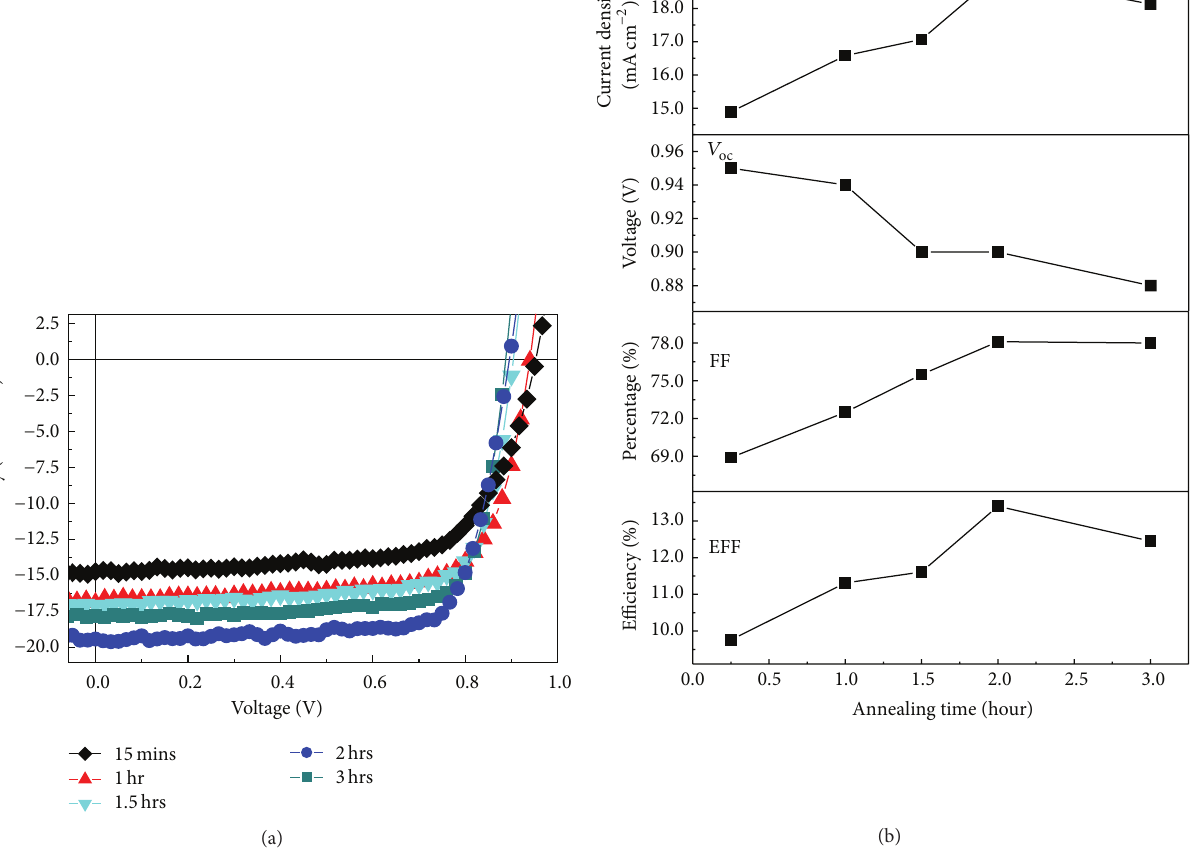
Figure 7: Electrical performance of devices with MAPbI 3 perovskite films annealed at 105 ∘ C for varying annealing times: (a) J-V curves of the devices under simulated AM 15 irradiation (100mWcm −2 ); (b) variation of device parameters, 𝐽 sc , 𝑉 oc , FF, and PCE, with increased annealing times. Reproduced from [21] with permission from the Royal Society of Chemistry.